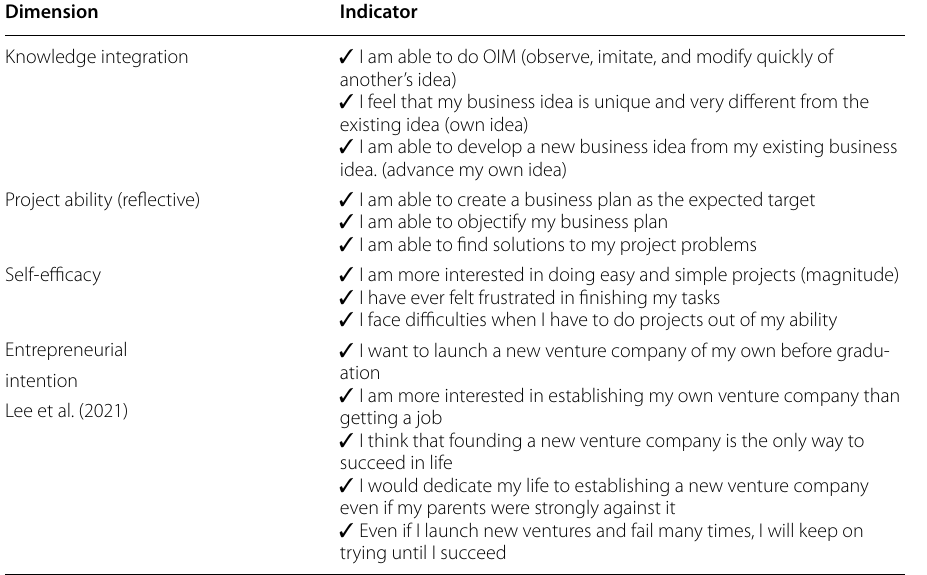
Table 2 Dimensions and indicators as research interview protocols Dimension